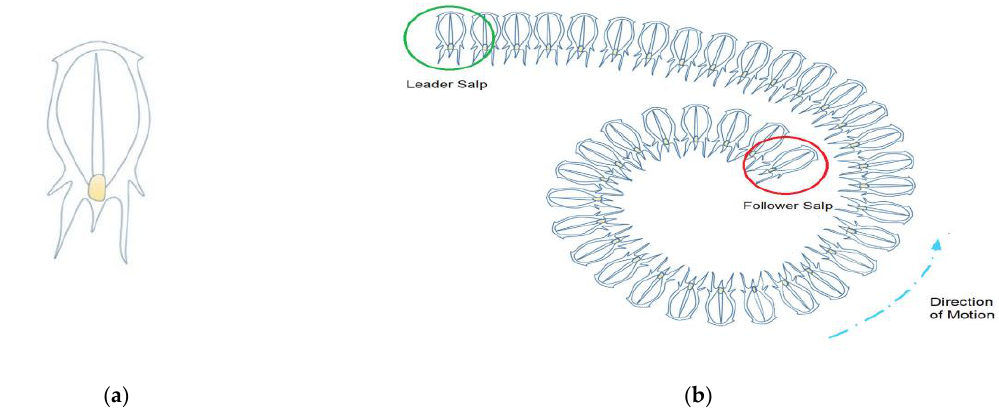
Figure 10. Swarm of salps. ( a ) Individual salp; ( b ) salp chain [74].